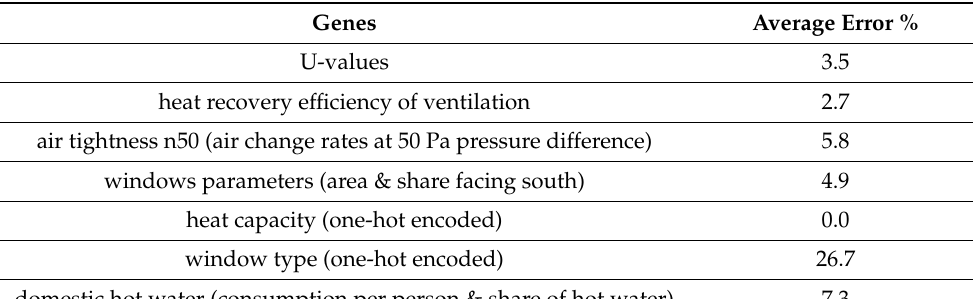
Table 2. The success of the identification method.